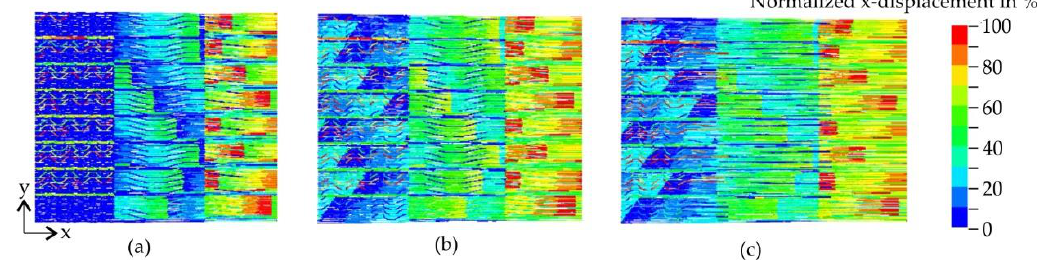
Figure 10. Simulation results of gradient fabric GW1: displacement of the warp yarns at different total strain values: ( a ) 10%, ( b ) 20%, and ( c ) 30%.